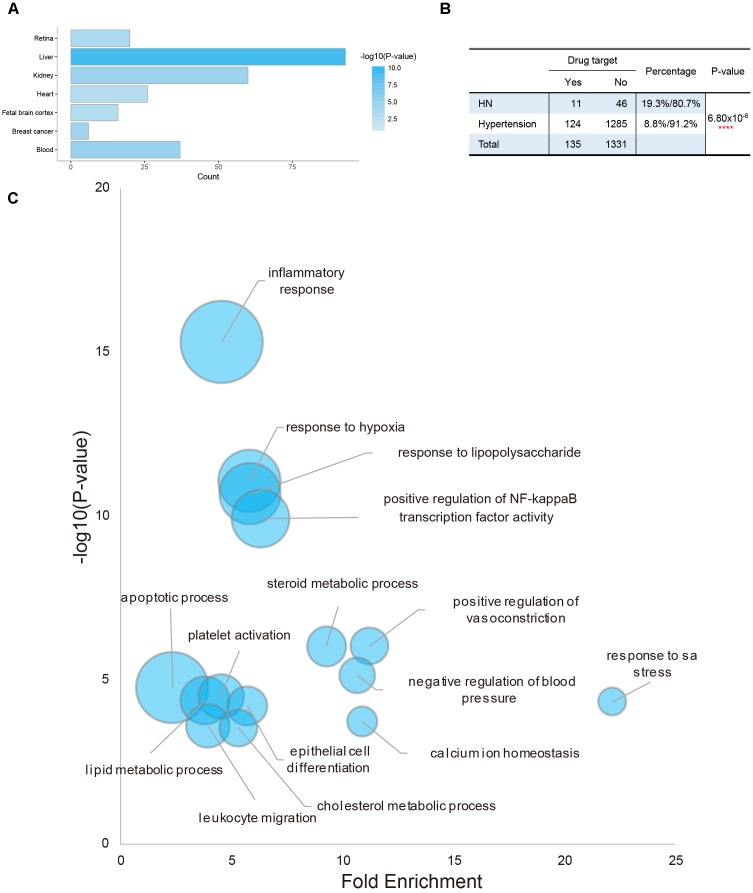
Tissue enrichment and functional enrichment of potential targets of QDZJN. (A) Histogram of possible target tissue of QDZJN’s potential targets by tissue expression enrichment in DAVID. X-axis is the count of targets, and color gradient of bar is related with p-value of enrichment analysis. (B) Chi-square test table for comparison of the distribution of QDZJN’s targets in disease gene of hypertension and HN. (C) Bubble diagram of enriched GO terms of QDZJN’s targets. X-axis is fold enrichment, Y-axis is related with p-value of enrichment analysis. Bubble size changes with the count of targets in this term.